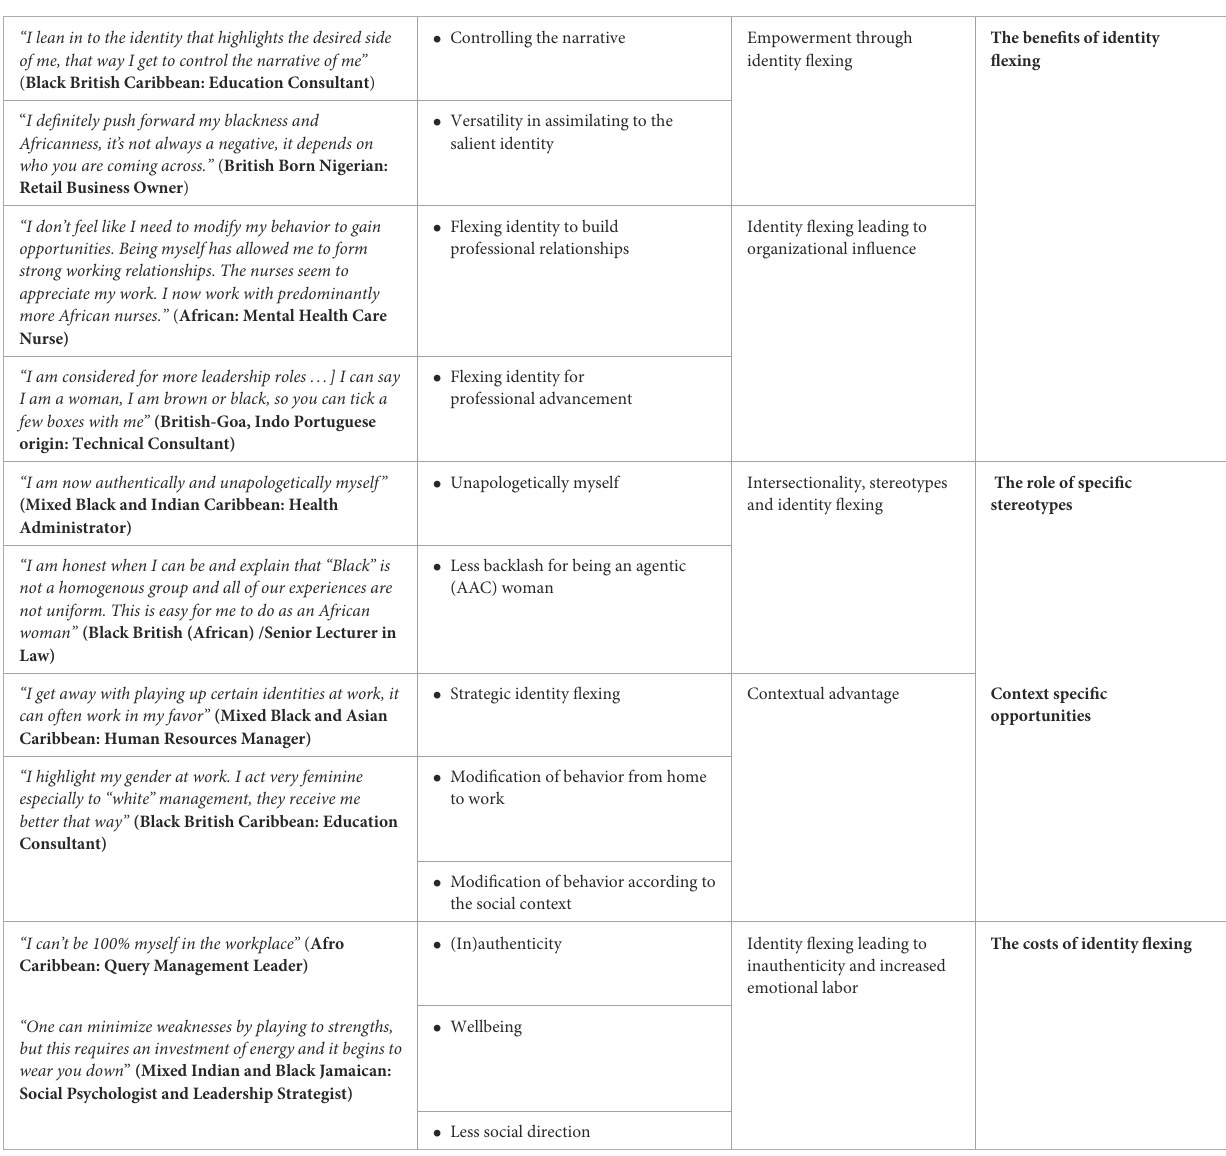
TABLE 2 Initial codes, emergent clusters and final